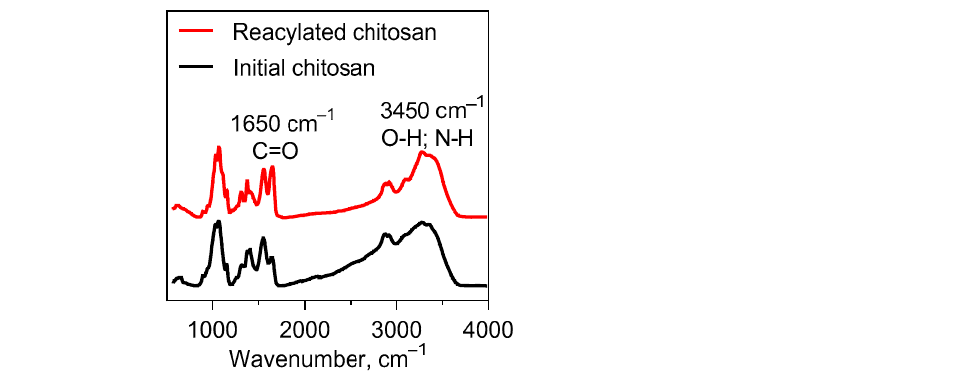
Figure 7. Infrared spectroscopy for the initial and reacylated chitosan.